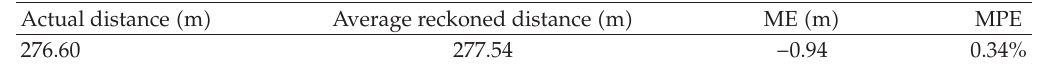
Table 4: Result of field test Scenario 2 (cid:2) 10 trails (cid:3)